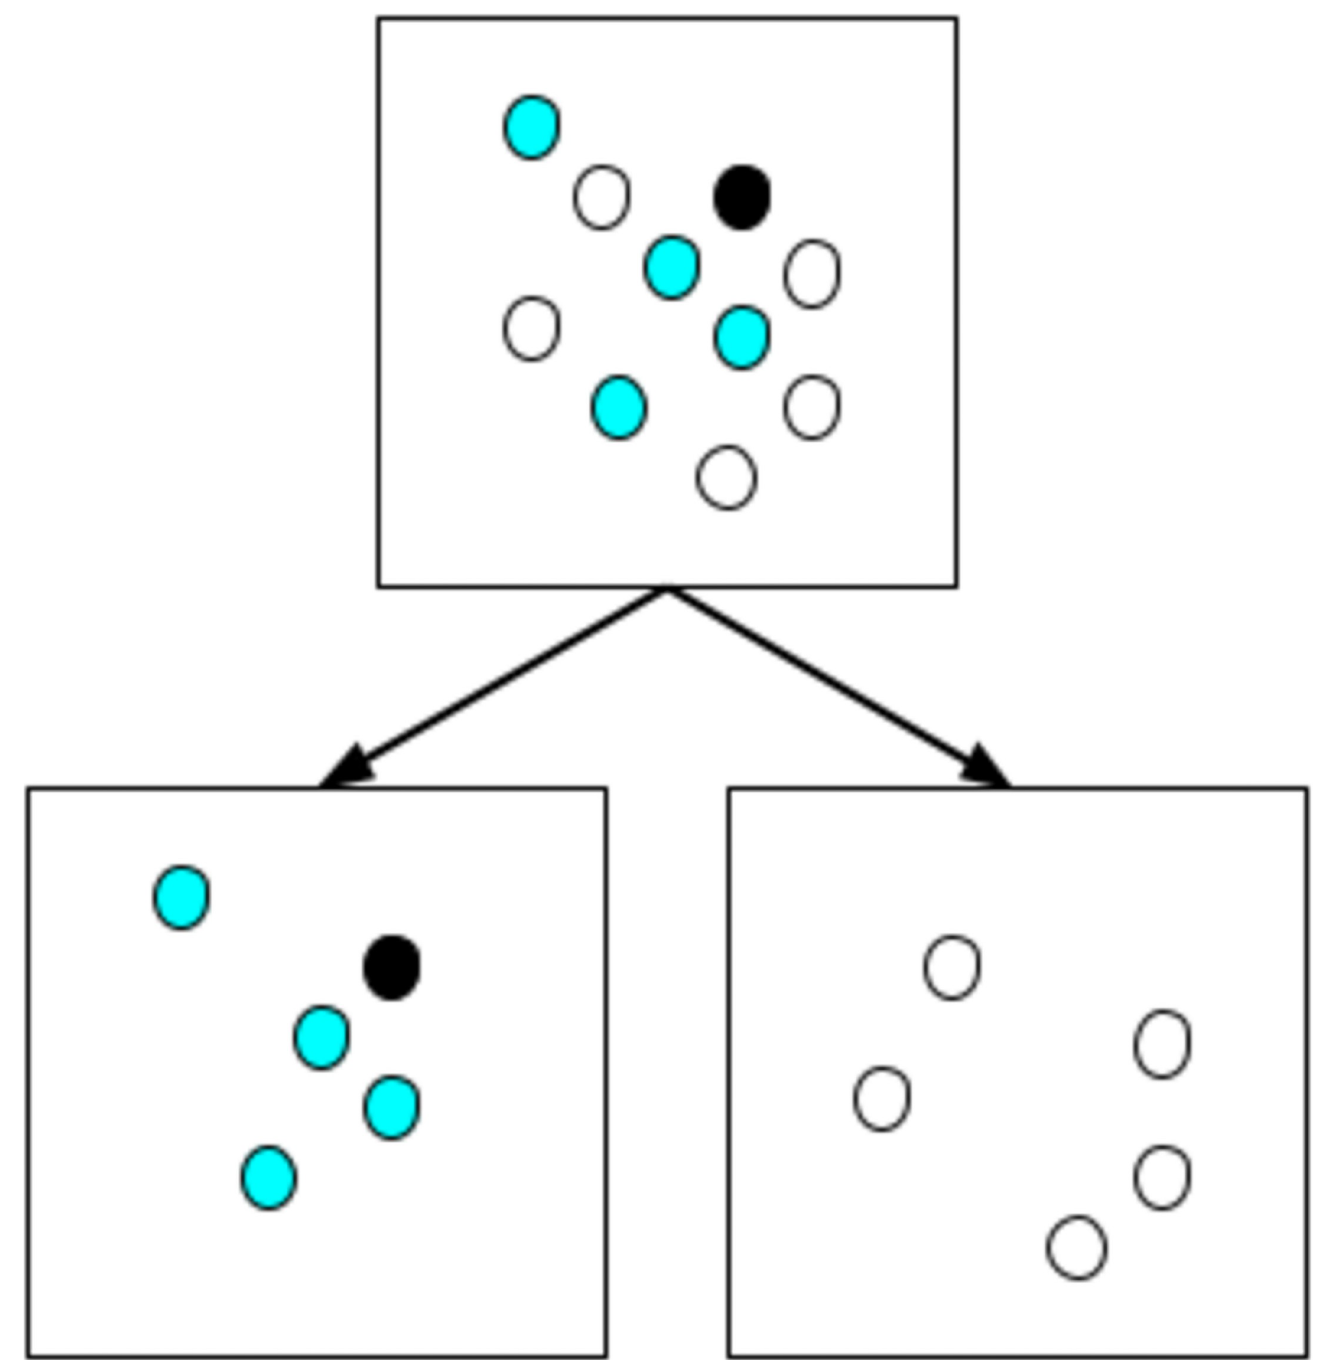
Fig 16. Effect of dividing a group of 10 persons into two groups of 5 persons each. In the original situation, each of the 9 susceptible persons (white and cyan) has a probability to get infected of p 0 , resulting in a expected number of infected persons of 9 p 0 . In the divided situation on the left, the expected number of infections is 4 p 0 . On the right, it is 0. Overall, this results in an expectation value of 1 attendance, the number of infections is reduced from 9 p 0 to 2 p 0 . For large group sizes, the reduction converges to 1/4. The same holds when each individual attendance is decided randomly with probability 1/2 at the beginning of each day.